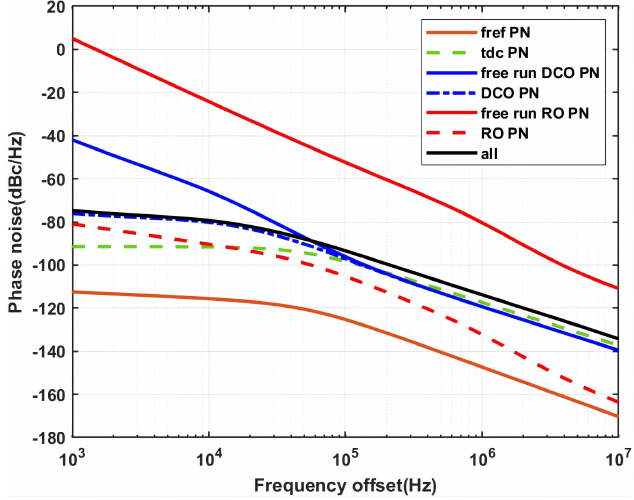
Figure 8. ADPLL phase noise contributed by DCO and RO with AK v = 160 kHz. ( a ) ω BW = 100 kHz. 20 MHz; ( b ) ω BW − IL